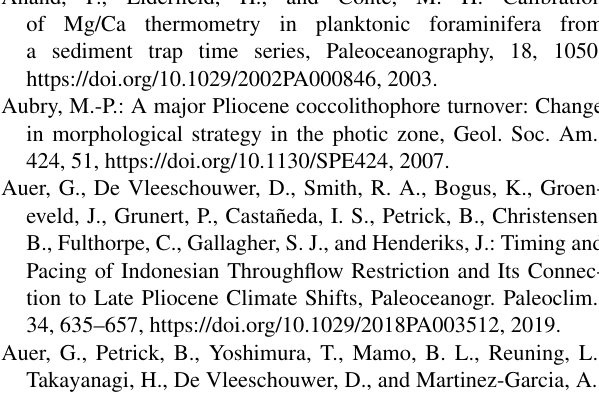
(cid:48) ) and GDGT- 37